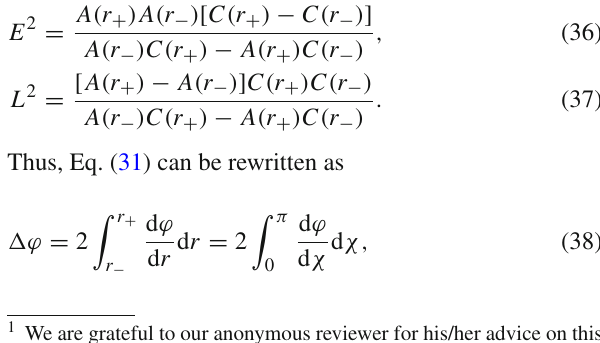
a periodic orbit and go back to its initial location exactly after a finite time. Otherwise, it runs a precessing orbit with an irrational number p . The precession per revolution of